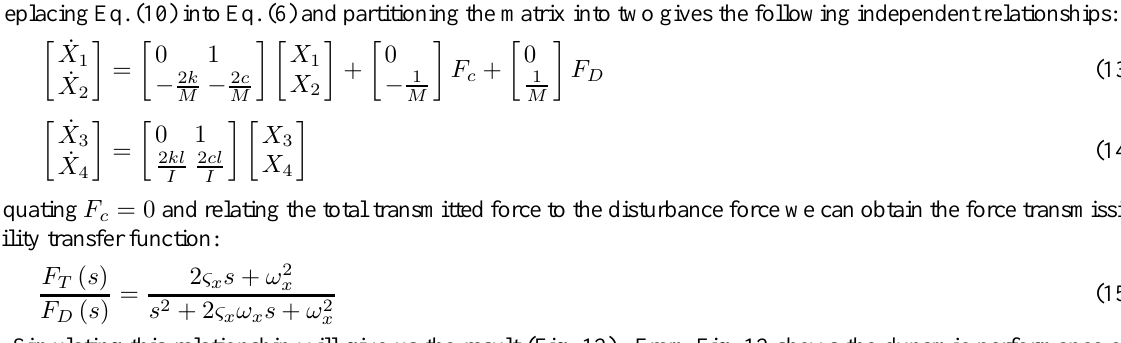
Fig. 12. Bode Plot of the force